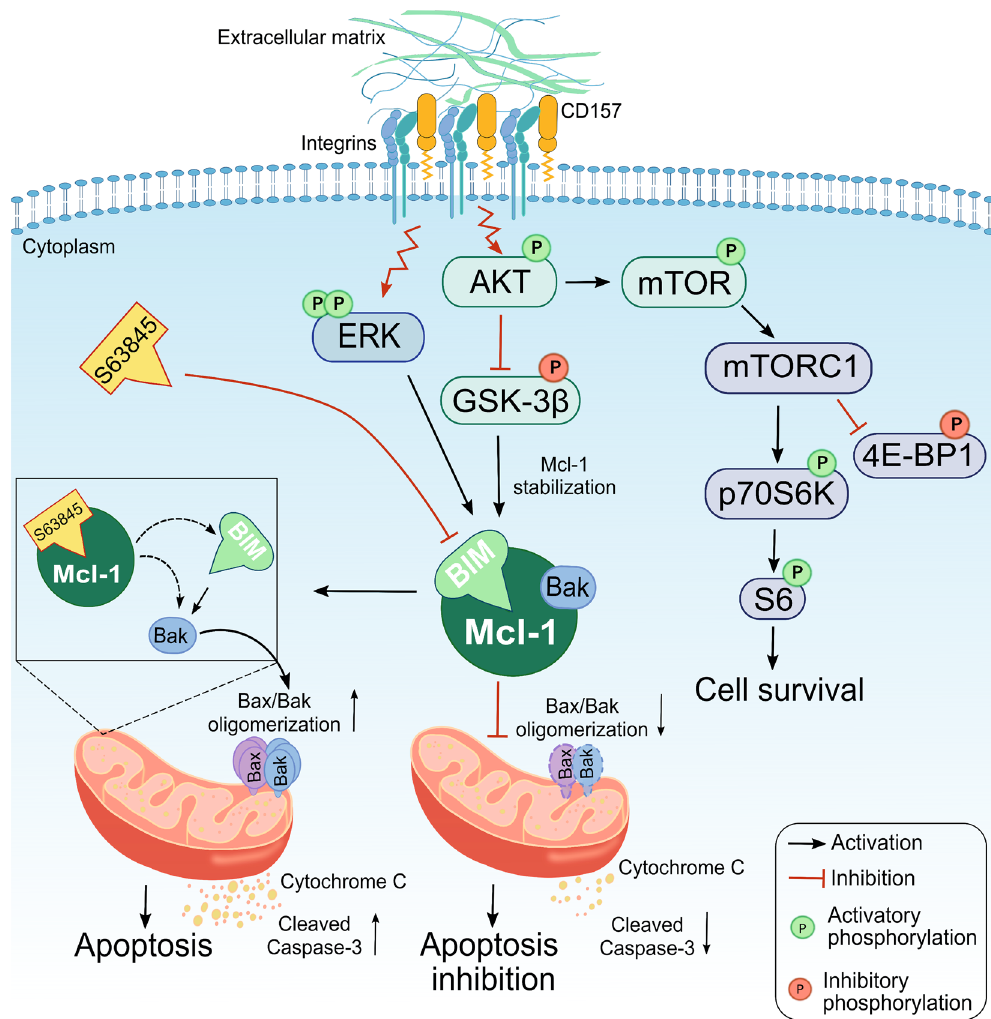
Figure 6. Schematic representation of CD157-mediated survival in AML cells. CD157 binding to fibronectin in AML cells promotes structural and functional interaction of CD157 with specific integrins. This activates intracellular signals leading to phosphorylation of AKT, mTOR and its downstream substrates p70S6K, pS6 ribosomal protein, 4E-BP1, and ERK. In turn, phosphorylated AKT inactivates its major target GSK-3β, which loses its pro-apoptotic function and favors the stabilization of Mcl-1. The increased expression of Mcl-1 strengthens its ability to sequester Bim and Bak, thus precluding the Bak/Bax oligomerization at